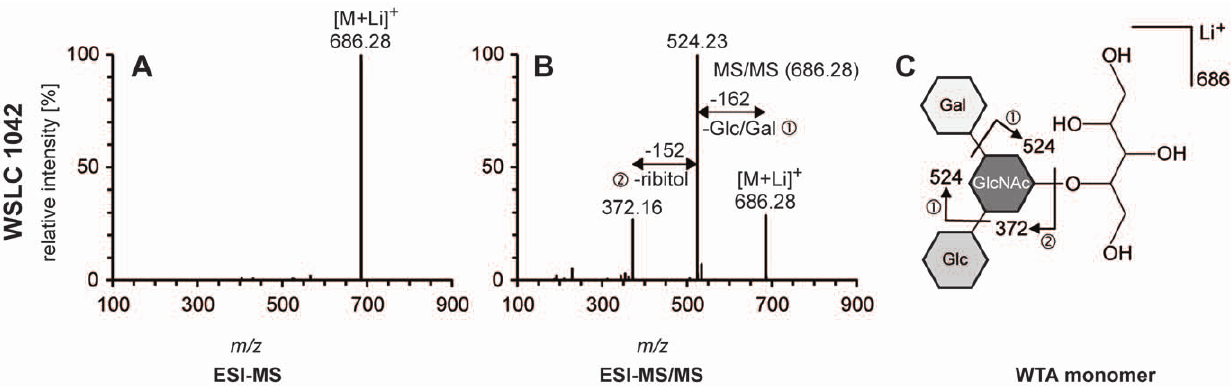
Figure 2. ESI-MS/MS analysis of WTAs of Listeria strain WSLC 1042. ( A ) Basic peak [M + Li] + of the ESI-MS at m/z 686.28. ( B ) Product ion spectrum obtained by ESI-MS/MS for the [M + Li] + ion at m/z 686.28. ( C ) Schematic structure and fragmentation pattern of WTA monomer of L. monocytogenes strain WSLC 1042. Peak labels show the measured m/z values. Fragment ions are indicated by arrows.